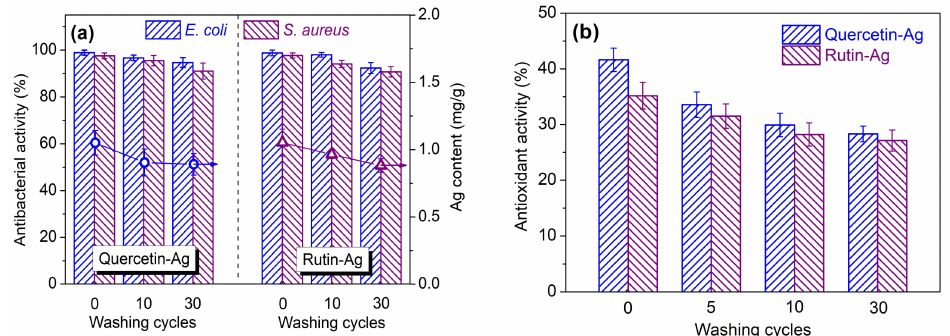
Figure 11. Washing durability of the antibacterial ( a ) and antioxidant ( b ) activities of the silk fabrics treated with AgNPs synthesized using quercetin and rutin.